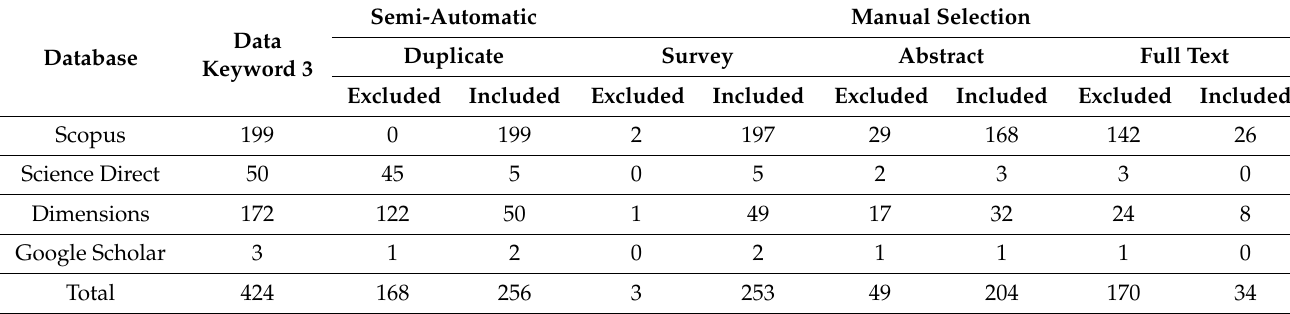
Table 3. Results of the semi-automatic and manual